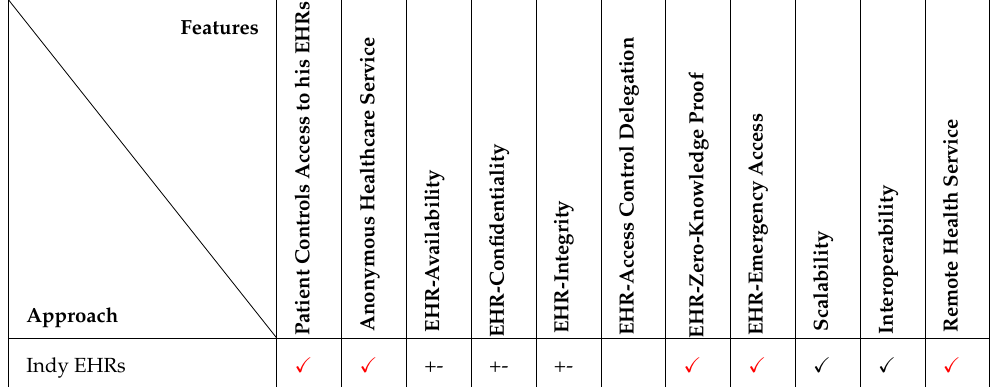
Table 6. Features of the solution based on